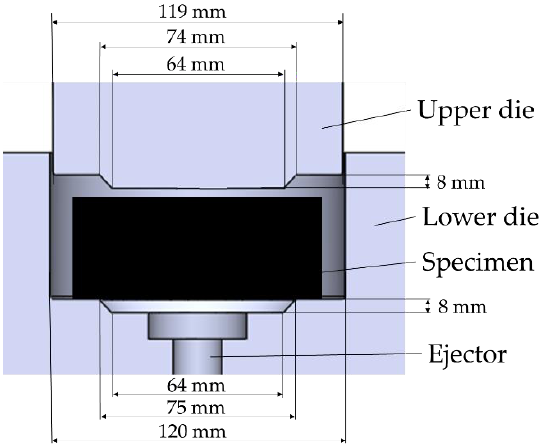
Figure 2. Schematic of the die.